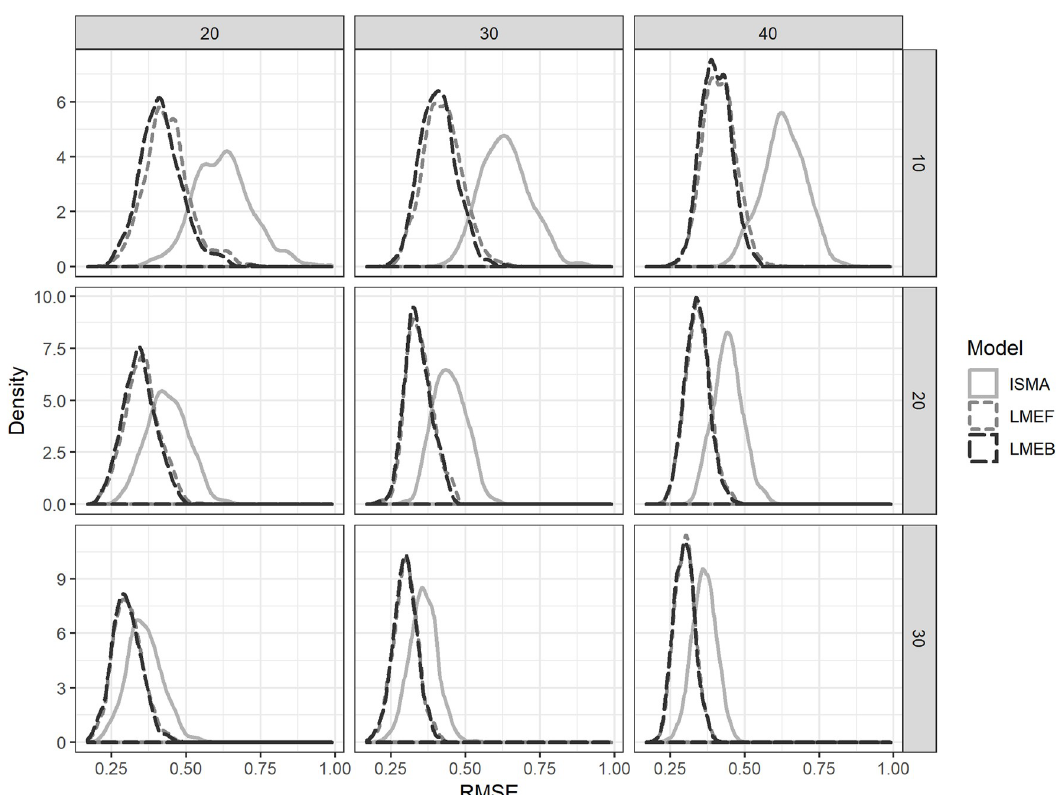
Fig 2. Empirical distribution of RMSE values for β i , the person-specific treatment effect relative to the control condition, over 1,000 replicates per condition for the individual-subject meta-analysis (ISMA) and the frequentist mixed models (F-LME) and Bayesian mixed models (B-LME) by number of subjects (columns; 20, 30 or 40 subjects) and number of measurements per subject (rows; 10, 20 or 30 measurements per condition).